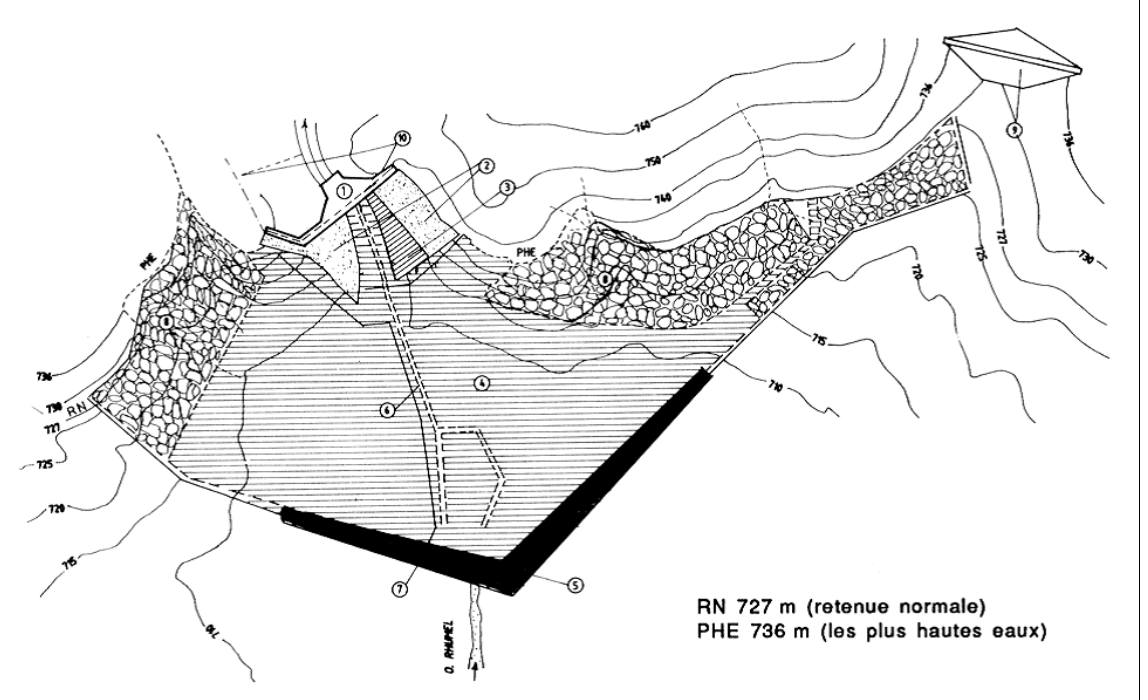
Figure 11. Diagram of the waterproofing work carried out during the construction of the dike of Hammam Grouz